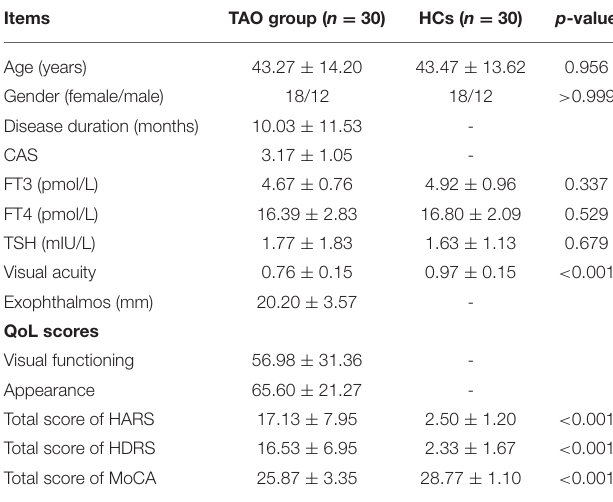
TABLE 1 | Demographic and clinical characteristics of the group with TAO and HCs.